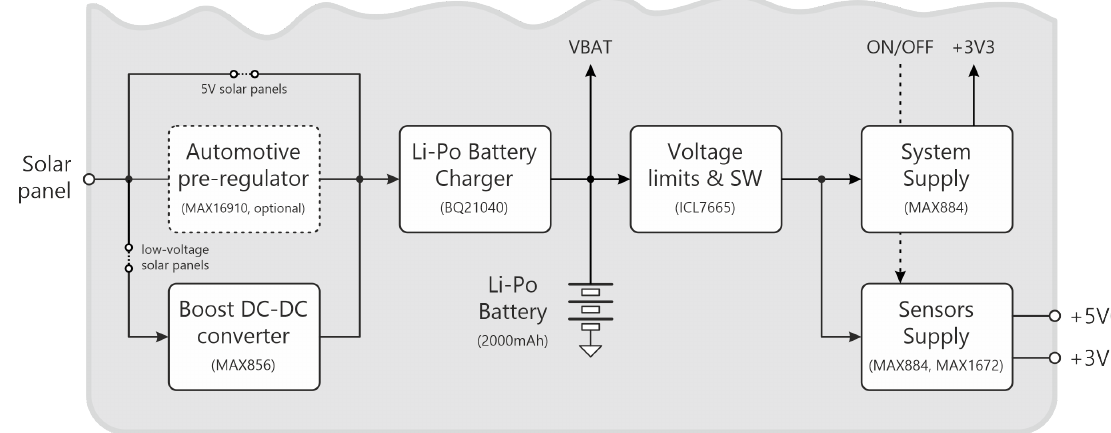
Figure 2. SPWAS’21 power management sub-circuit.